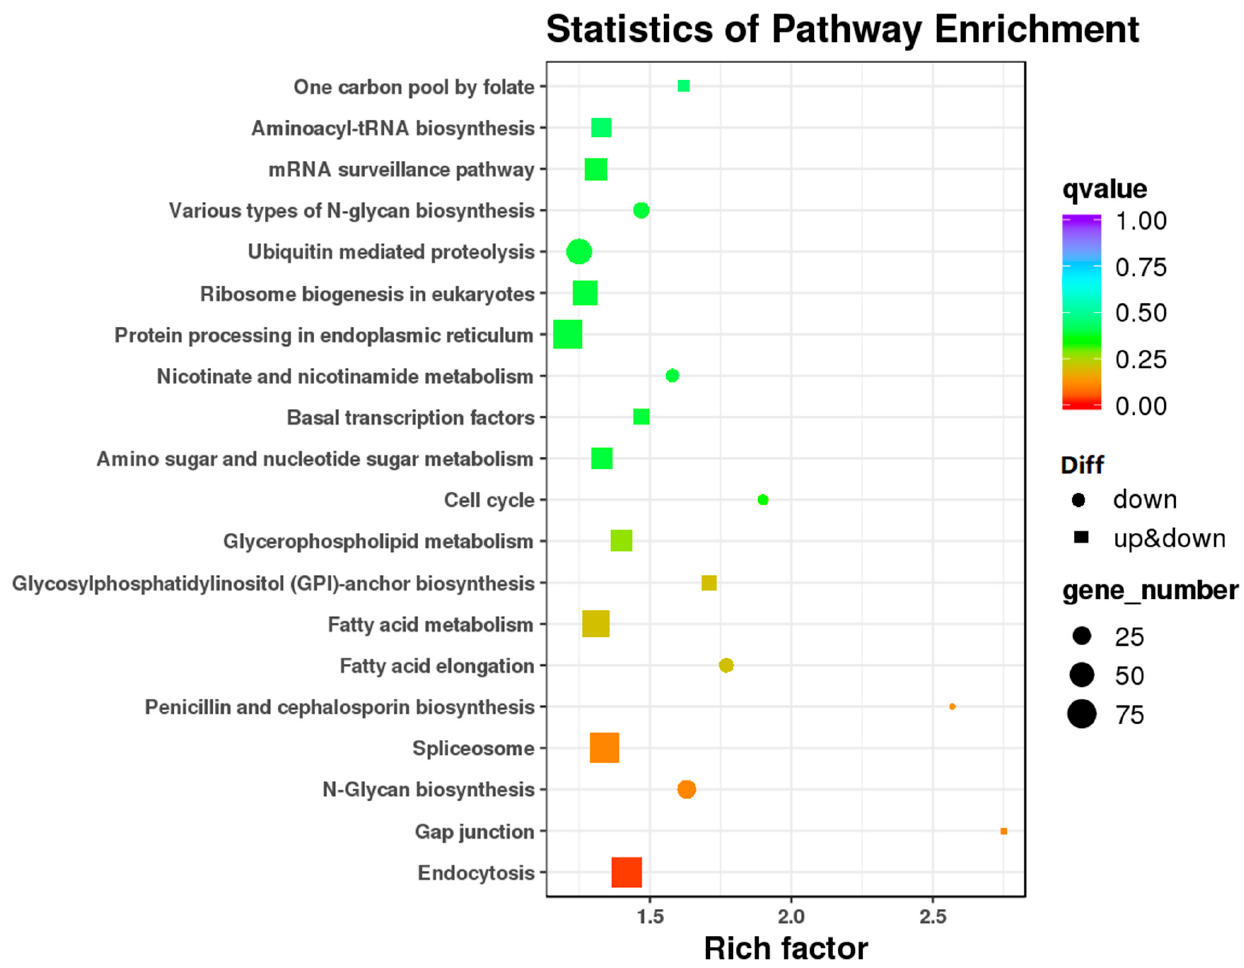
Figure 4. The scatter diagram of the enriched KEGG pathway of DEGs in IL vs. L. Y -axis: pathway; X -axis: Enrichment factor. The color of the dots stands for q-value. ‘Diff’’ represents differential expression. Circle represents the downregulated DEGs in this pathway, and rectangle represents the upregulated and downregulated DEGs in this pathway. The size of the dots represents the number of DEGs enriched in this pathway. IL represents the one-year post-infected larva of H. xiaojinensis by O. sinensis . L represents the pre-infected larva of H. xiaojinensis.